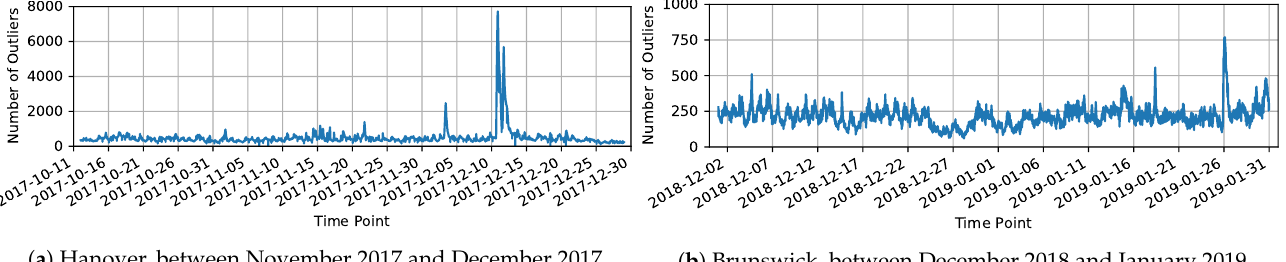
Figure 6. Number of affected units per time